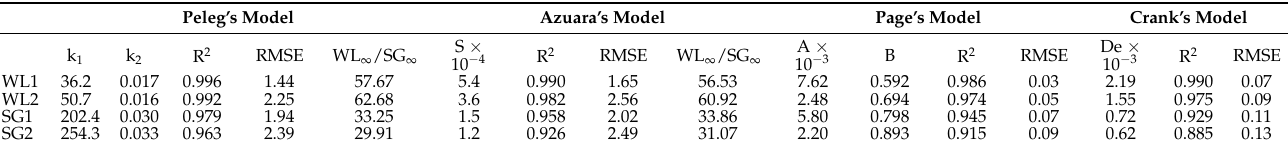
Table 2. Values of the models’ parameters and diffusion coefficients for water loss and solid gain.